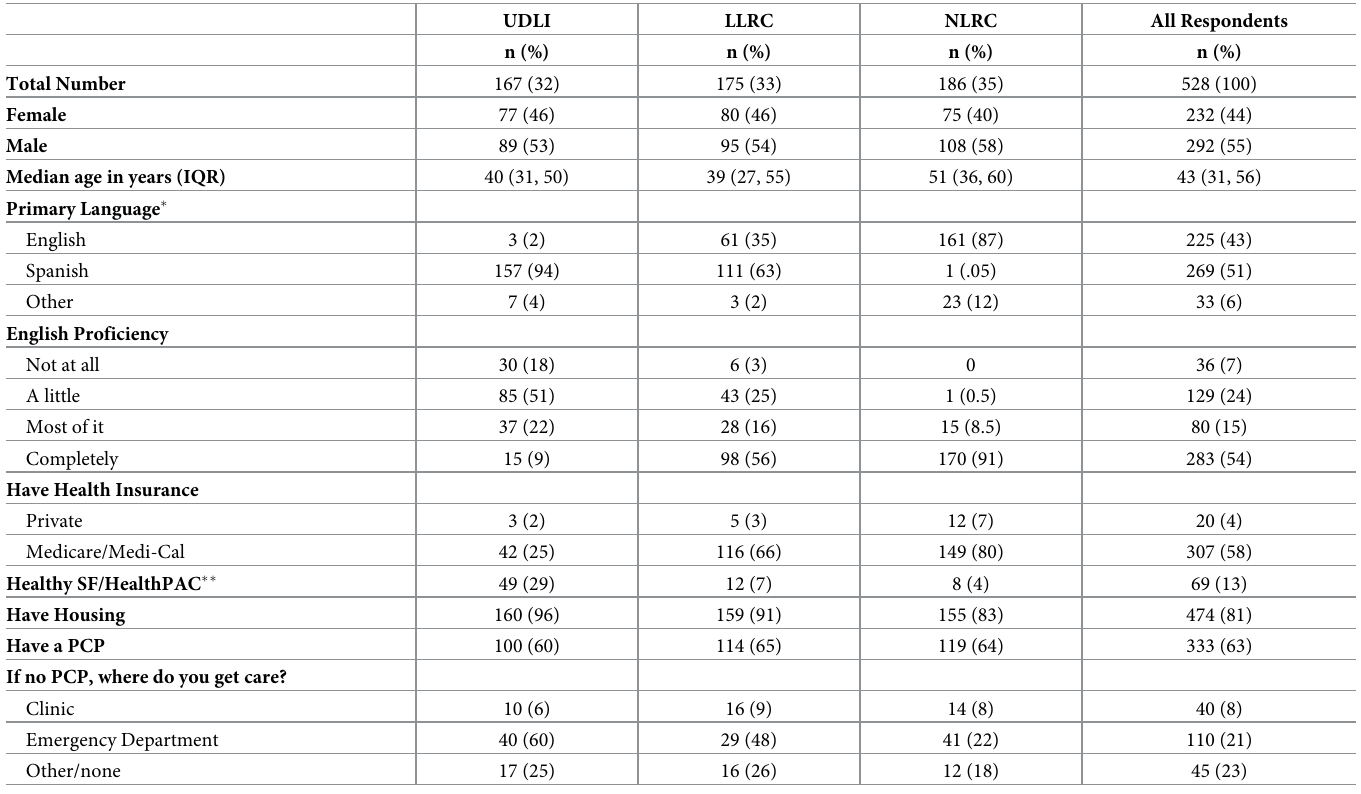
Table 1. Patient characteristics sorted according to study groups. UDLI LLRC NLRC All Respondents n (%) n (%) n